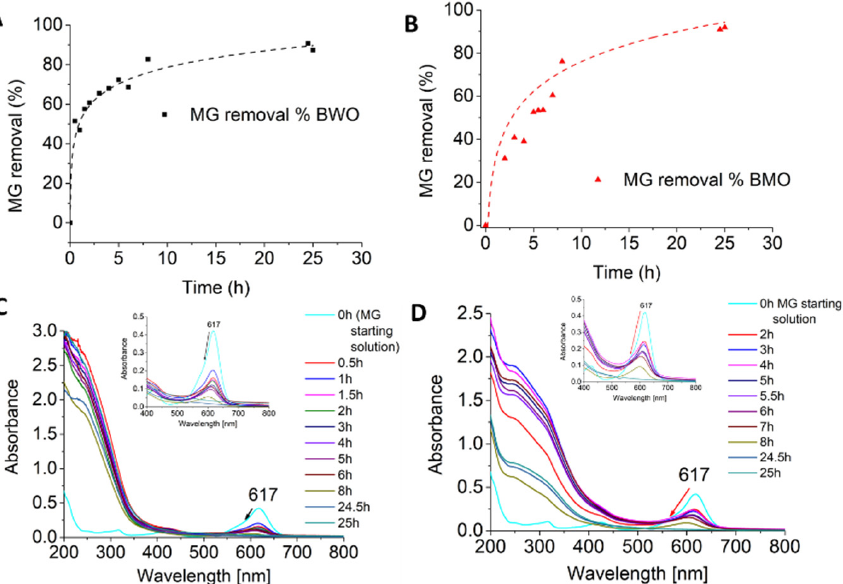
Figure 4. ( A ) Kinetic study for MG removal by BWO and ( B ) BMO. ( C ) Spectra of MG removal vs. time by BWO and ( D ) by BMO.